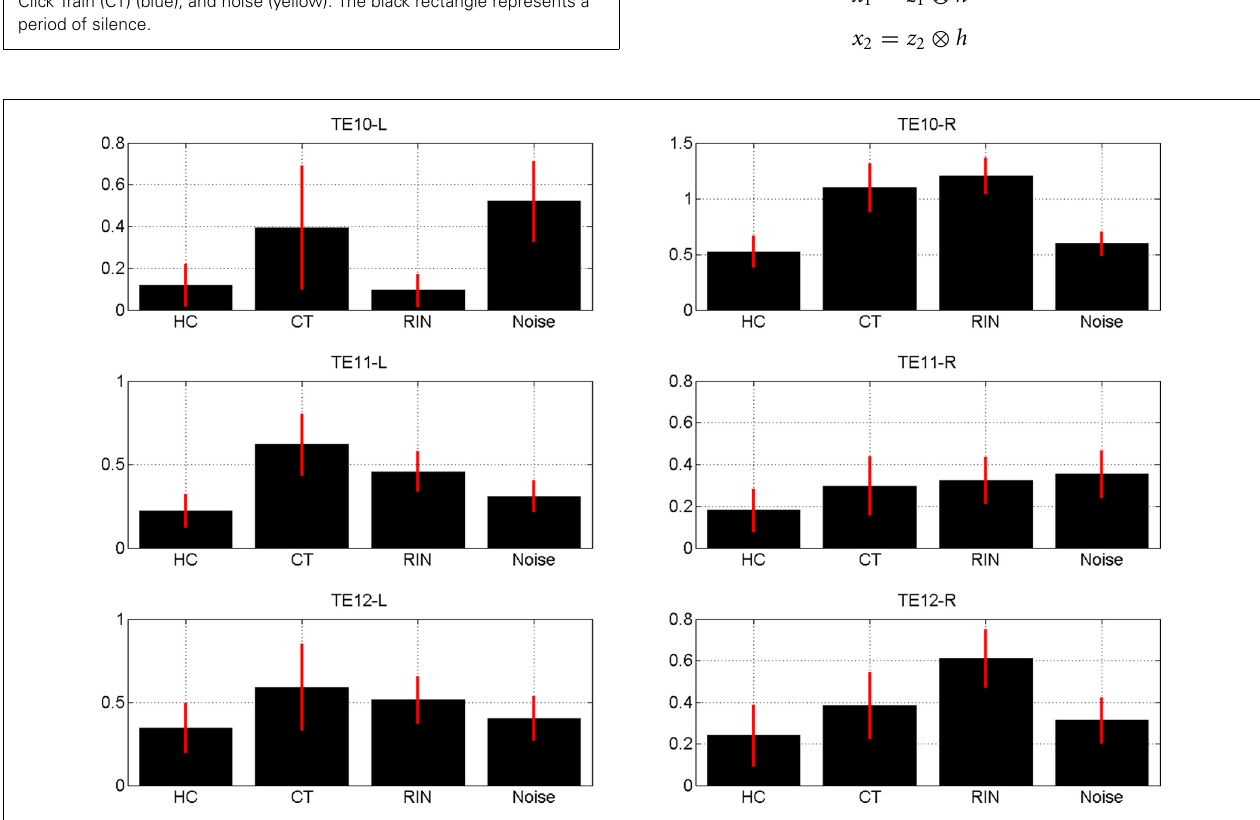
standard deviations. Estimates are shown for the six regions of interest; TE10, TE11, and TE12 indicate primary, medial, and lateral regions of Heschl’s Gyrus, and -L/-R indicates left/right